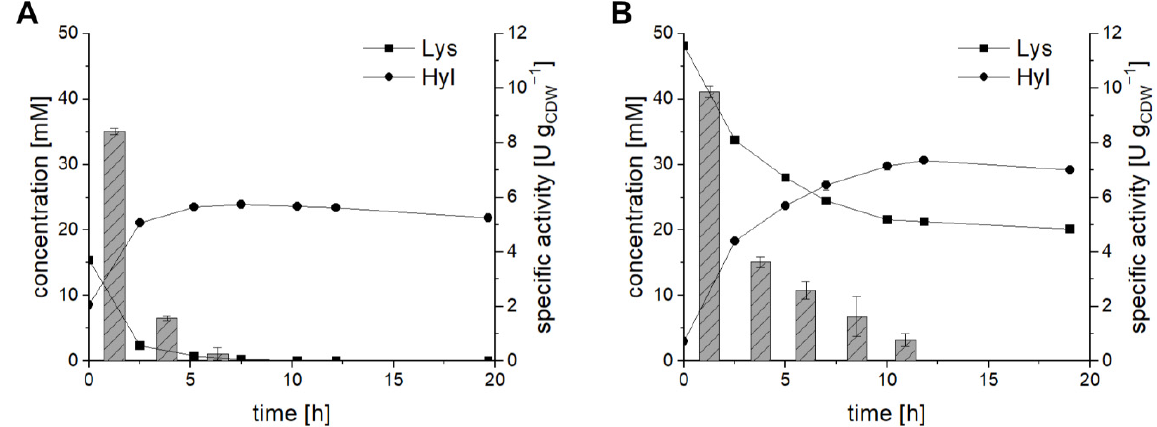
Figure 7. Progress curve of the whole-cell biotransformation on a preparative scale with E. coli BL21 (DE) pET-24a(+)- Plum KDO; ( A ) 25 mM Lys (initial concentration), ( B ) 50 mM Lys (initial concentration). Specific activities were calculated from the respective product concentrations between the sampling times. Biotransformation was performed in 50 mL at 30 °C and 180 rpm. The reaction mixture contained 10 g CDW L − 1 cells in 50 mM KPi buffer pH 7.4. Error bars are a result of technical duplicates.